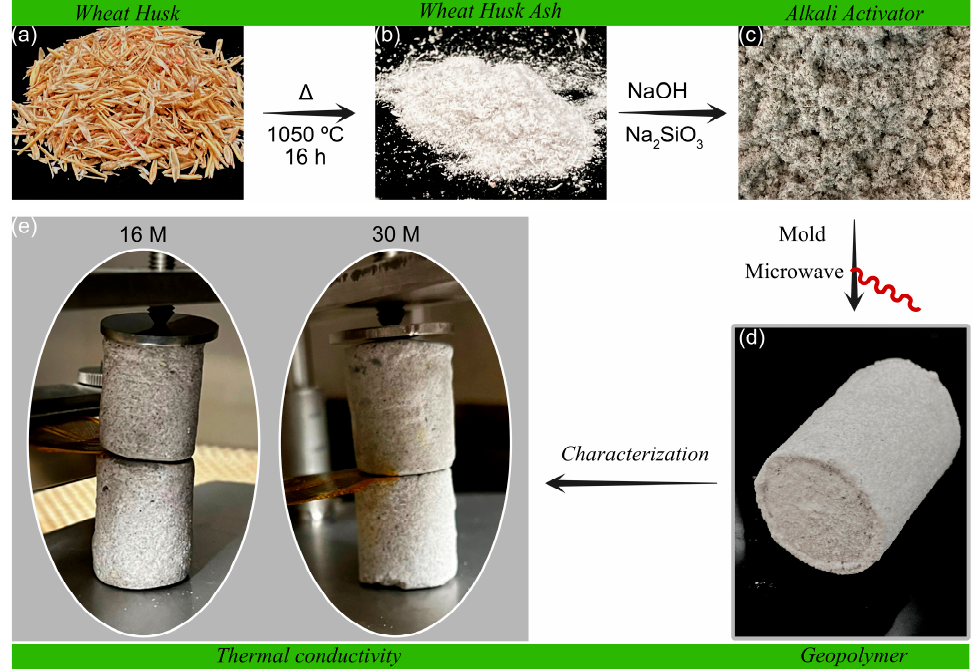
Figure 1. Flow diagram of the manufacturing process of geopolymers and their characterization: ( a ) wheat husk (WH); ( b ) wheat husk ash (WHA); ( c ) mixture of WHA with alkaline activator; ( d ) geopolymer; ( e ) thermal conductivity characterization. Table 1. Geopolymer formulations consisting of wheat husk ash (WHA), sodium hydroxide (NaOH), and sodium silicate (Na 2 SiO 3